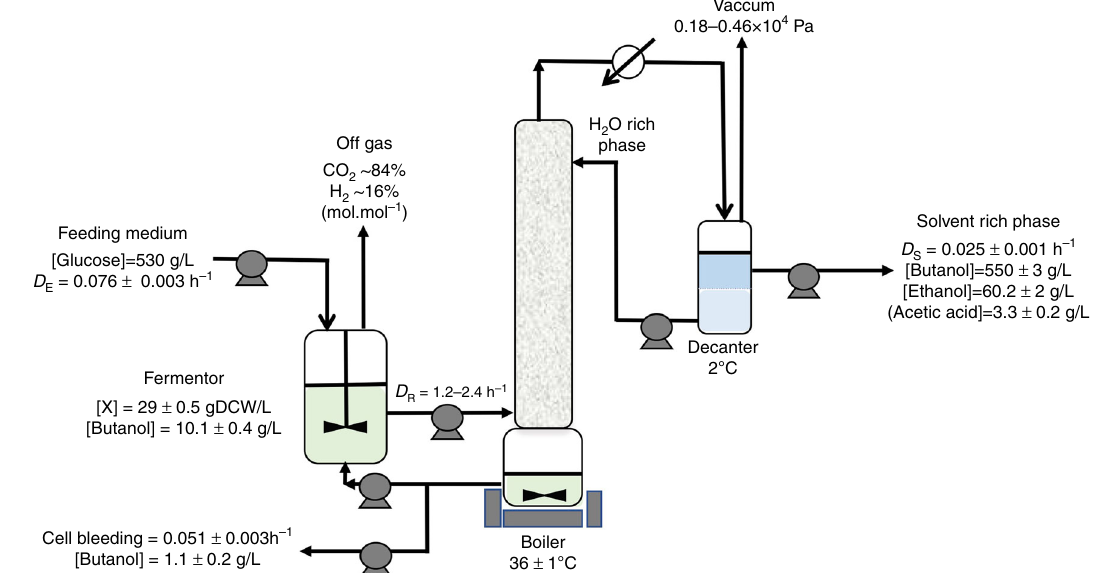
Fig. 4 Schematic representation of the extractive continuous fermentation process. The fermentor, boiler, and decantor have working volumes of 0.5 L, 0.3 L, and 0.1 L, respectively. For more details see